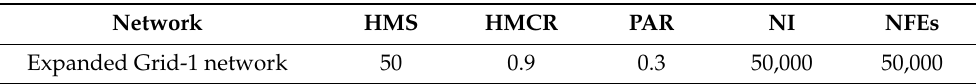
Table 3. Optimal parameter set of the MOHS.